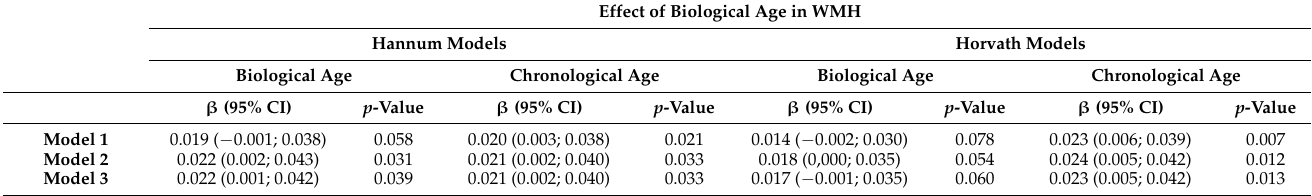
Table 2. All models have been constructed entering log-WMHv as the dependent variable and biological age estimations and chronological age as independent variables. Model 1: adjusted for C-age and hypertension. Model 2: Model 1 + sex, diabetes, hypercholesterolemia, smoking habit, alcohol consumption, stroke etiology (TOAST) and body mass index. Model 3: Model 2 + white cell count estimates (principal components). Values represent β coefficients, 95% confidence intervals (CI), p -values and valid observations in each